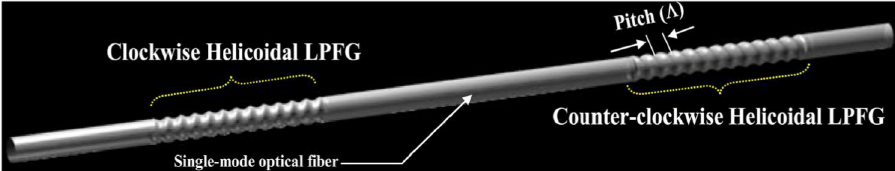
Figure 20. Schematic of the proposed bandwidth-tunable all-fiber BRF based on a HLPFG pair of opposite helicities. Adapted with permission from Ref. [78] © The Optical Society.